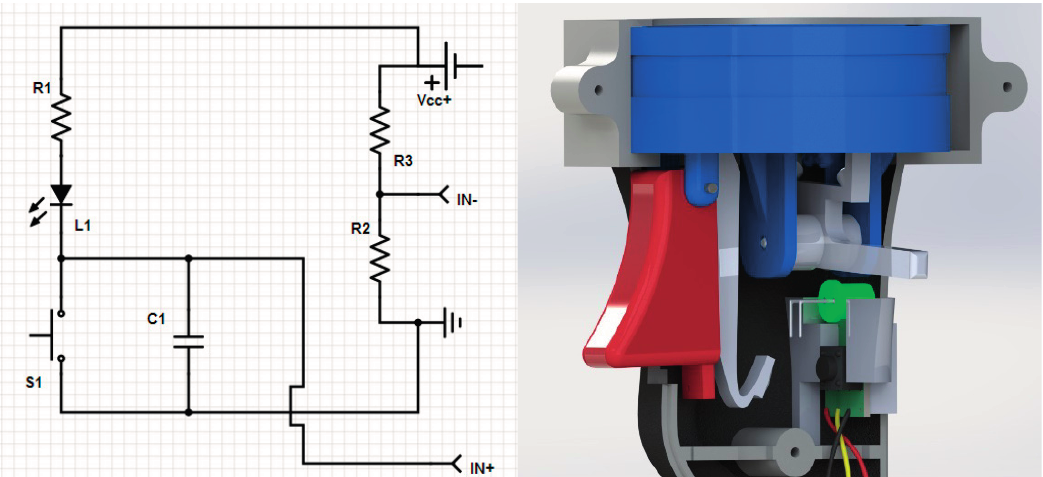
Figure 4. ( Left ) Electrical scheme for the triggering sensor; ( Right ) Details of the triggering mechanism.